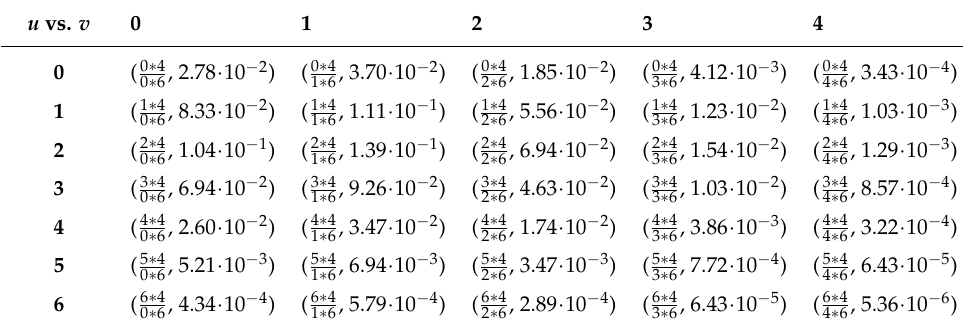
Table A3. Pairs of possible RRs and their associated probabilities ( h 1,2 , f 1,2 ) for the data in Table 2.